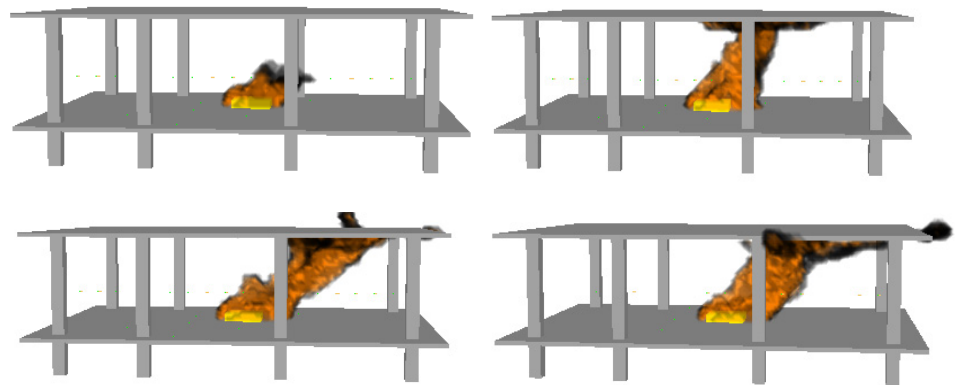
Figure 9. Flame shapes under the wind speed of 1.5 m/s.